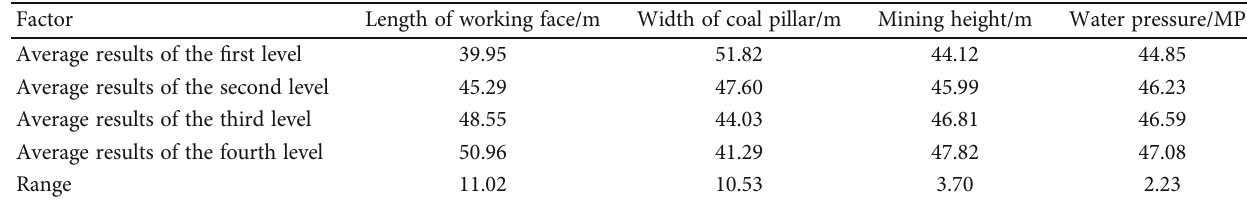
Table 4: Orthogonal experiment range analysis Tab. (maximum vertical stress).